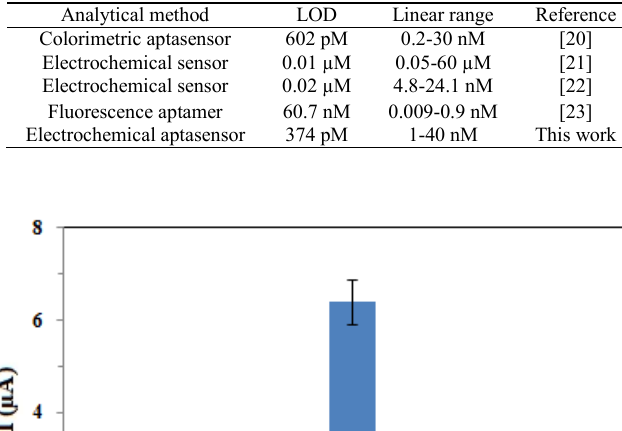
Table 1. Comparison between parameters obtained at different biosensors